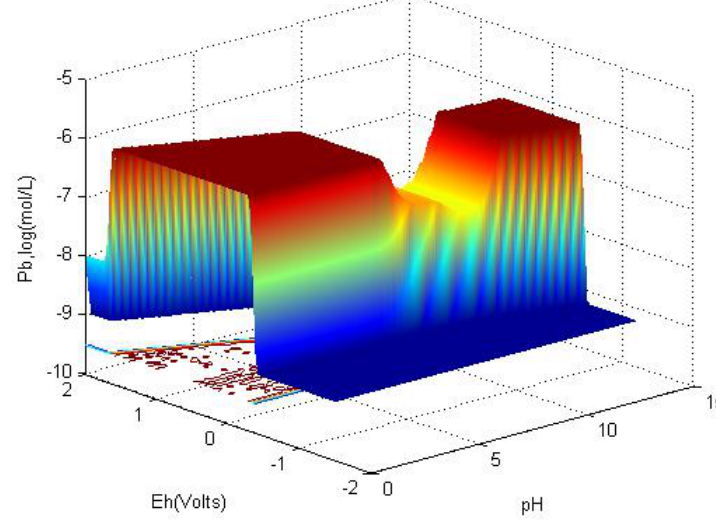
Figure 23. The Eh-pH plus solubility diagram for Pb–CO 3 –water. The yellow gulch area in the